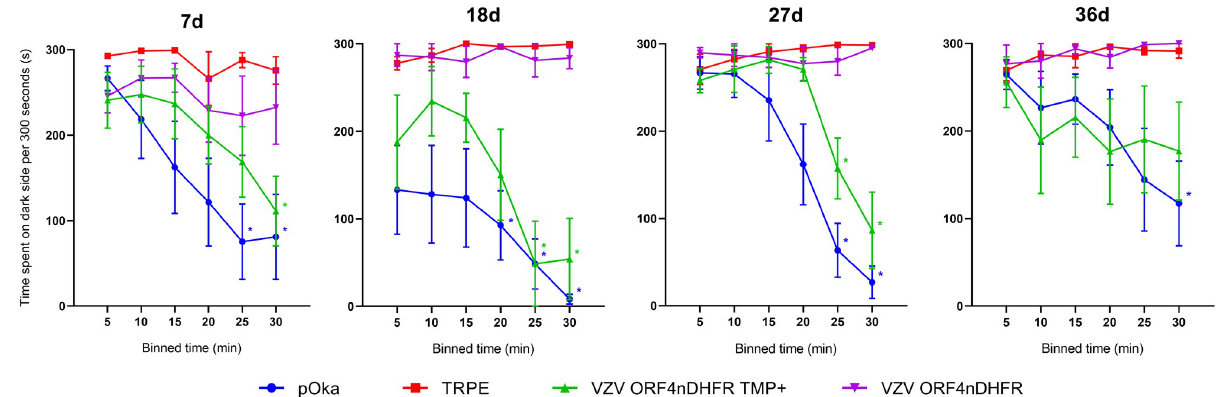
Fig 10. Affective pain develops following whisker pad inoculation with replication conditional VZV ORF4nDHFR only under permissive conditions. Male Sprague-Dawley rats (n = 6/group) received 2x10 5 PFU pOka (blue circle), VZV ORF4nDHFR with 500 nM TMP (green triangle) or without (purple triangle), or uninfected TRPE cell equivalent (red square). Hypersensitivity was measured at times post-infection (d) indicated above each graph using the same methods as Fig 7 and detailed in the methods section. Error bars: SEM. Statistics: Two-way ANOVA with Bonferroni multiple comparison to TRPE negative control where � p <